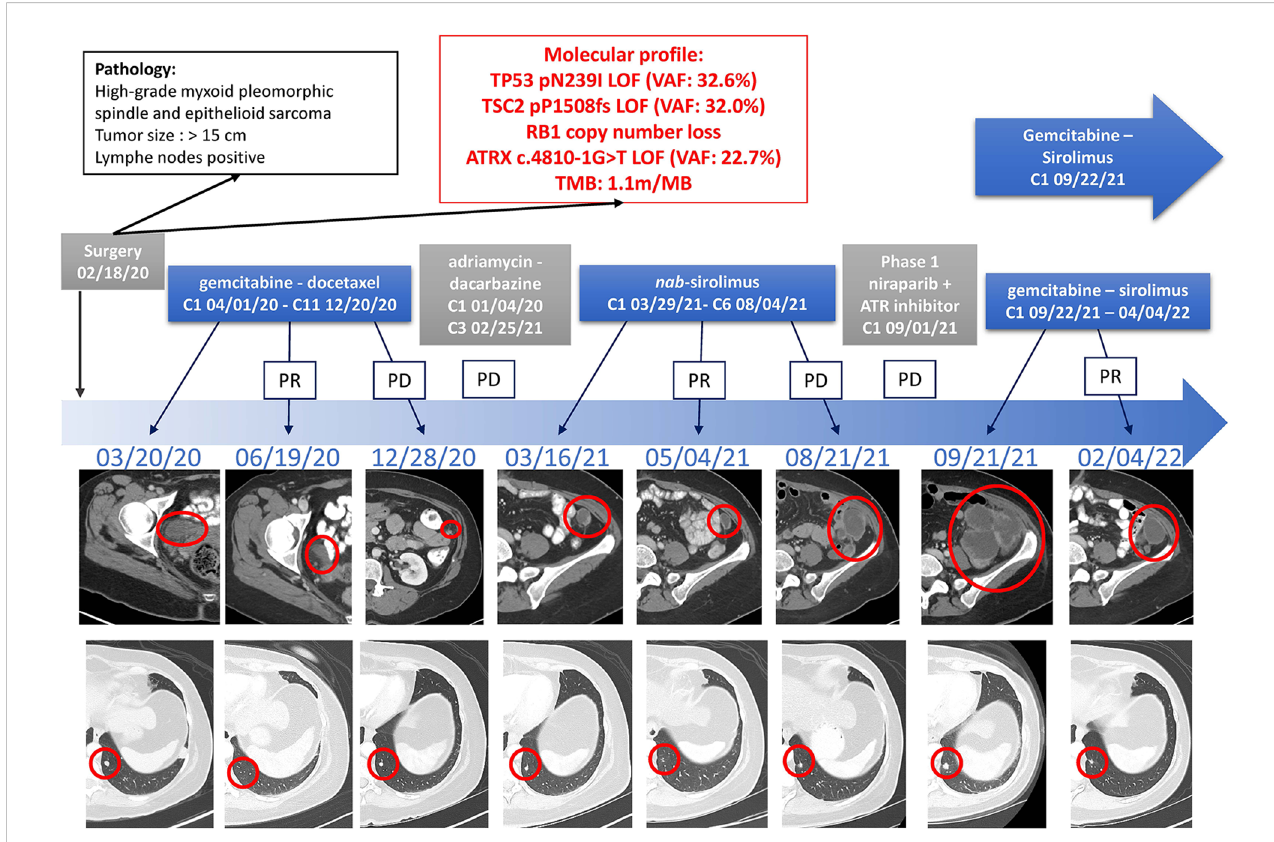
FIGURE 2 Timeline of Treatments of Patient 1. Treatment lines are displayed chronologically, with imaging assessments at baseline, at time of best response to treatment, and at time of end of treatment for each line of treatment. Initial pathology diagnostic and molecular pro fi les are displayed. IHC, immunohistochemistry; LOF, loss-of-function; MSI, microsatellite instable; PD, Progressive Disease; PR, Partial Response; TMB, tumor mutational burden; VAF, variant allele fraction